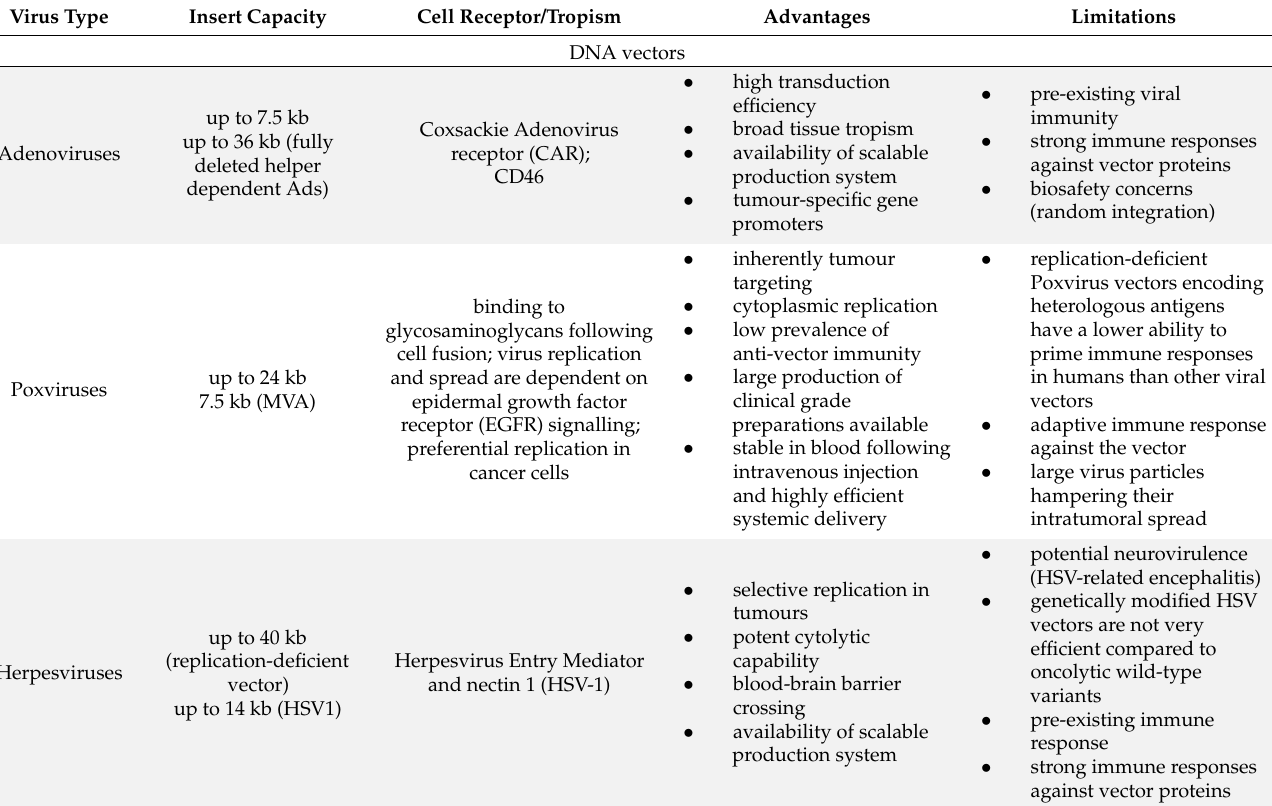
Table 1. Comparison of viral